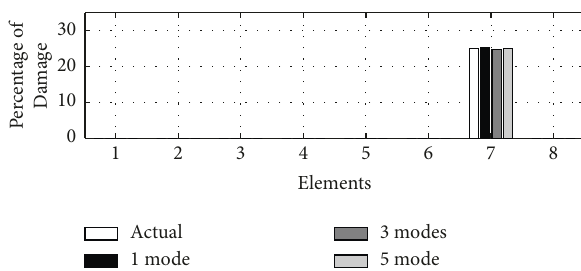
Figure 14: Damage extents obtained via EO in step 2 for the experimental simply supported beam.